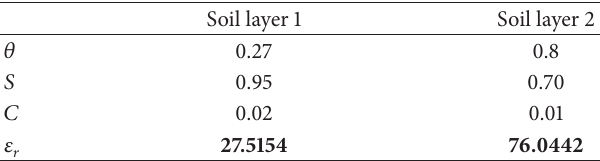
Table 1: Input soil electrical model.